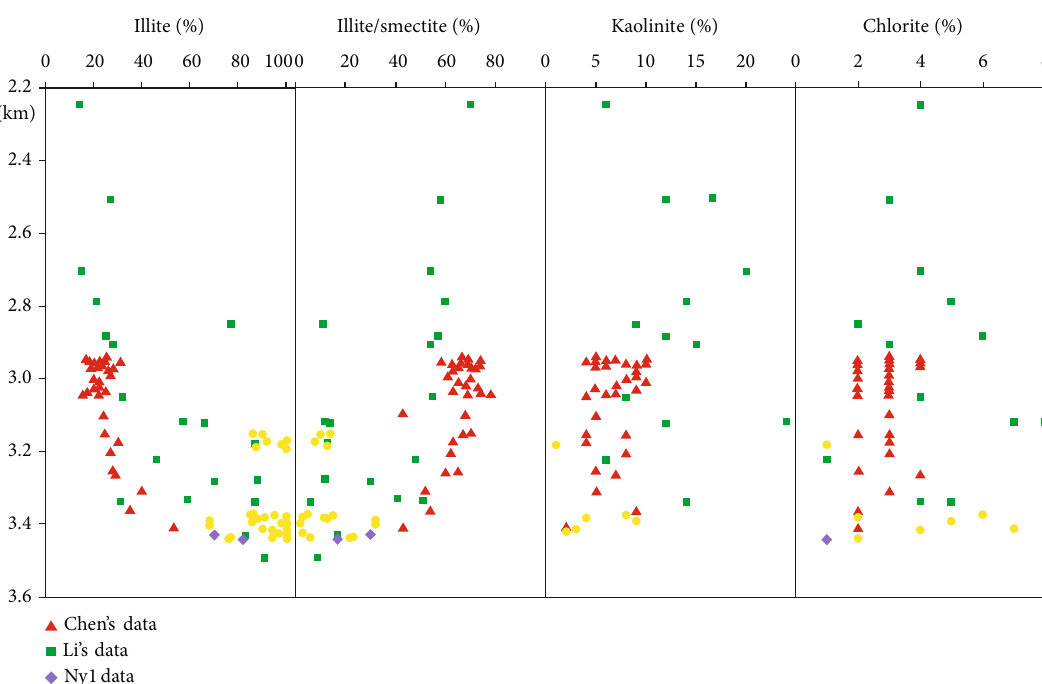
Figure 4: Proportions of clay minerals in samples from Es3 to Es4. Data are from the NY1 and FY1 wells; the data were collected for this study and from some previously published work on the study area [30,